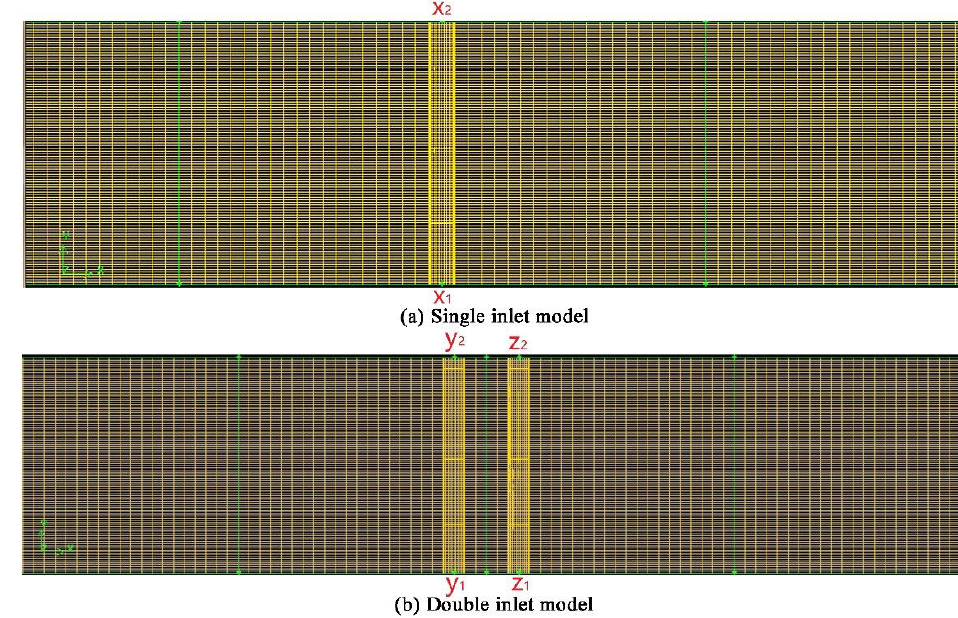
Figure 2. Schematic diagram of meshing. (( a ) Single inlet model, ( b ) Double inlet model).